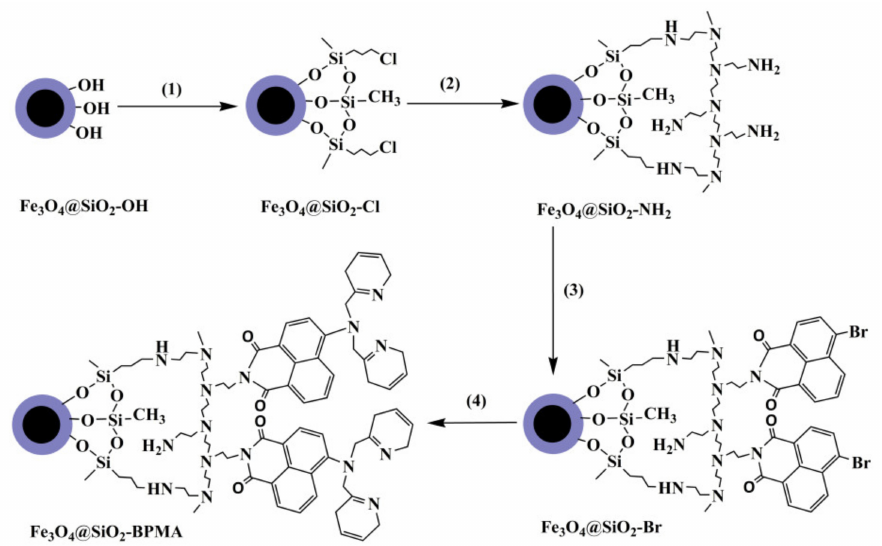
Figure 1. Synthesis of bis(2-pyridylmethyl)amine (BPMA)-functionalized Fe 3 O 4 @SiO 2 by a “grafting-from”